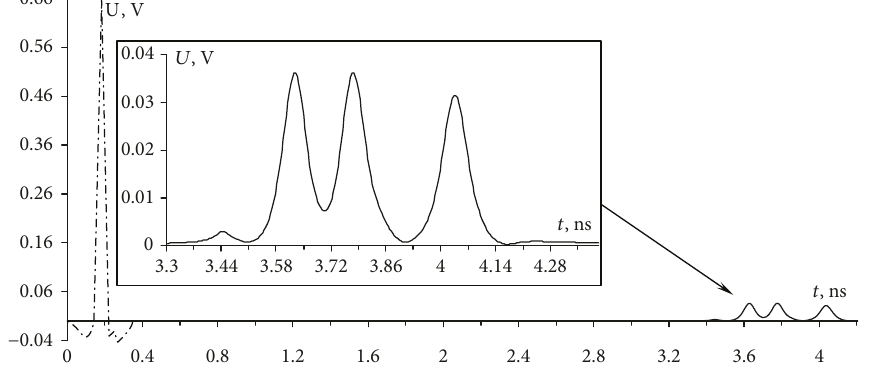
Figure 9: Voltage waveforms at the input ( – · – ) and output ( — ) (with enlarged fragment of the signal at the output) of a three-conductor microstrip line MF after optimization of parameters s